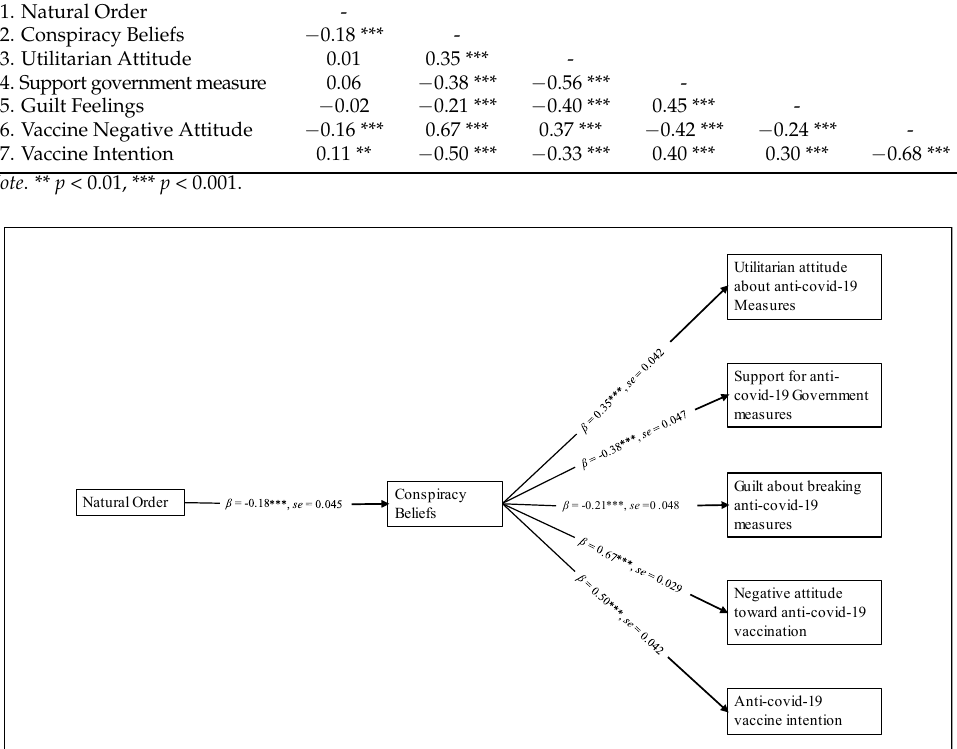
Figure 1. Path analysis model of the investigated variables. Note . *** p < 0.001. Table 2. Correlations.